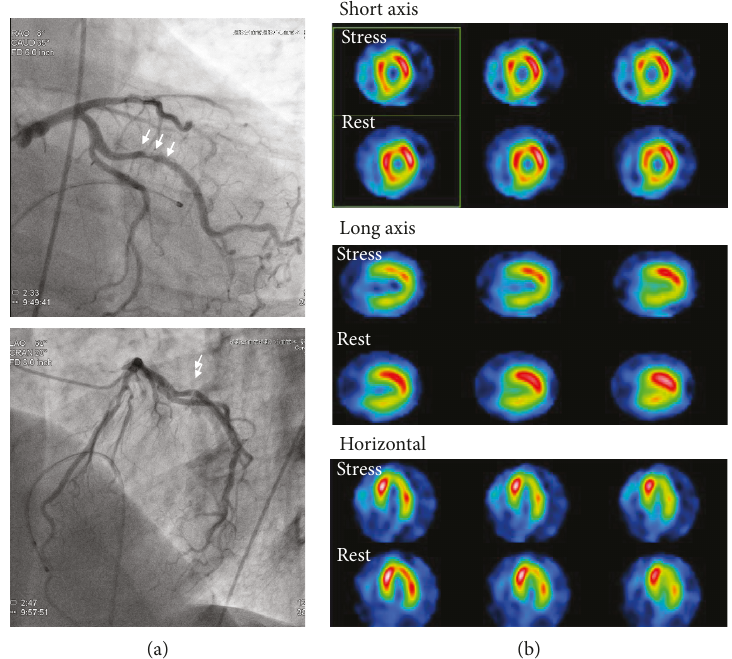
Figure 2: Second CAG and adenosine stress myocardial perfusion scintigraphy. (a) The second CAG was performed to investigate the acetylcholine-induced vasospasm. Although the coronary arteries did not exhibit vasospasm induced by acetylcholine, CAG revealed de novo stenosis in #12. (b) The adenosine stress myocardial perfusion scintigraphy (Tc-99m tetrofosmin) showed the myocardial ischemia in the posterior wall area, suggesting myocardial ischemia in #12.